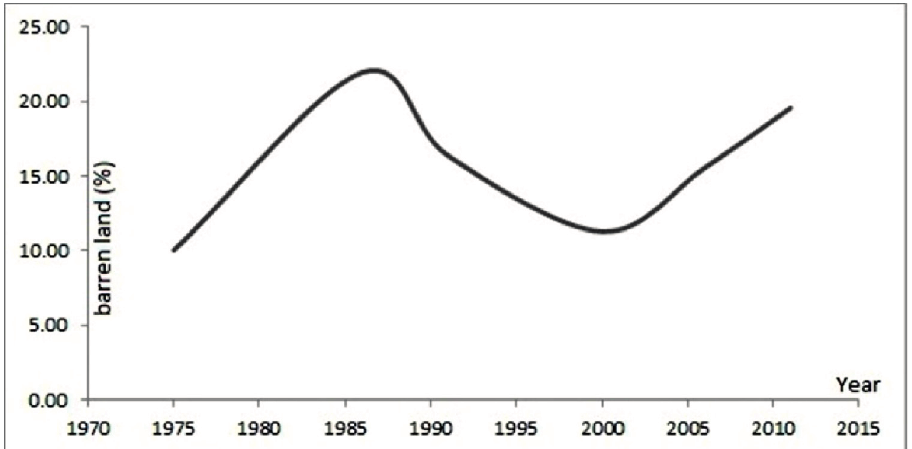
Figure 3. The dynamics of the barren land during the study period (percentage of barren land versus